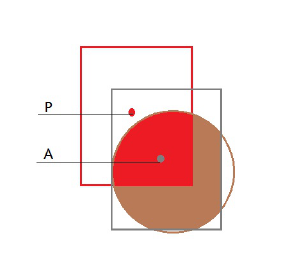
Figure 11: Schematic diagram of correcting error